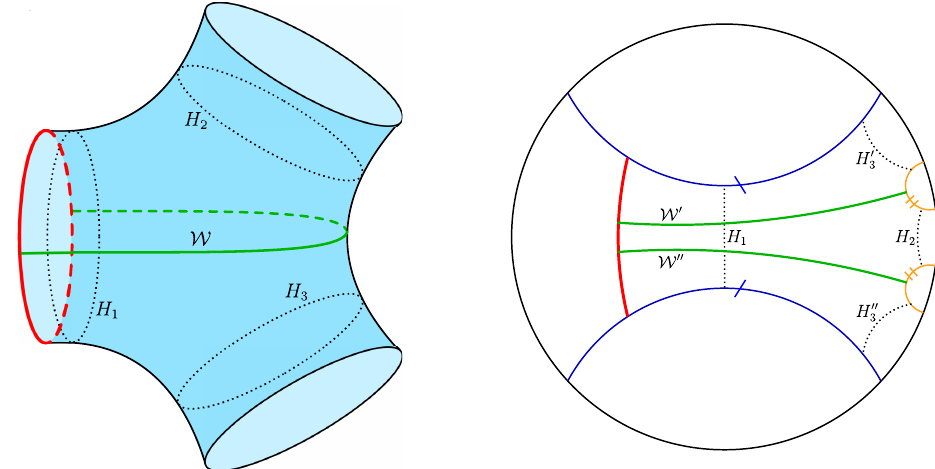
Figure 2. The pair of pants geometry with an end of the world brane (red) in one asymptotic region. On the left is a cartoon of the geometry of the t = 0 surface, and on the right is its description as a quotient of the Poincaré disc model. In the right picture the central region bounded by the blue and orange geodesics is a fundamental region for the identification. The geodesic W ≡ W 0 ∪ W 00 , which is the minimal geodesic anchored on the end of the world brane running in between the two asymptotic regions, is shown in green. The horizon H